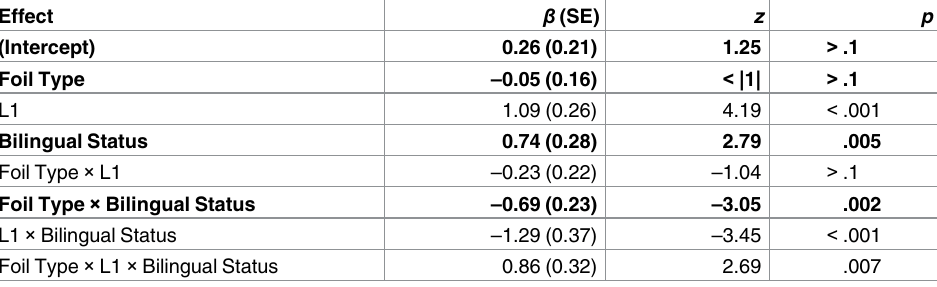
Table 5. Logit mixed-effects model with best fit on listeners’ accuracyin condition with F0 cues (with monolingual English listeners’ performance on non-word foils as baseline) a .